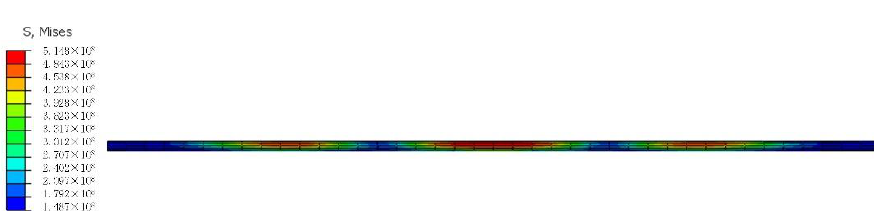
Figure 7. Displacement cloud map of pipeline.